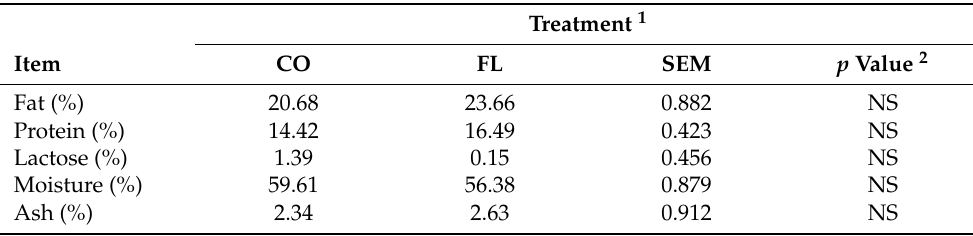
Table 6. Cheese composition of cows fed the experimental diets 1 .